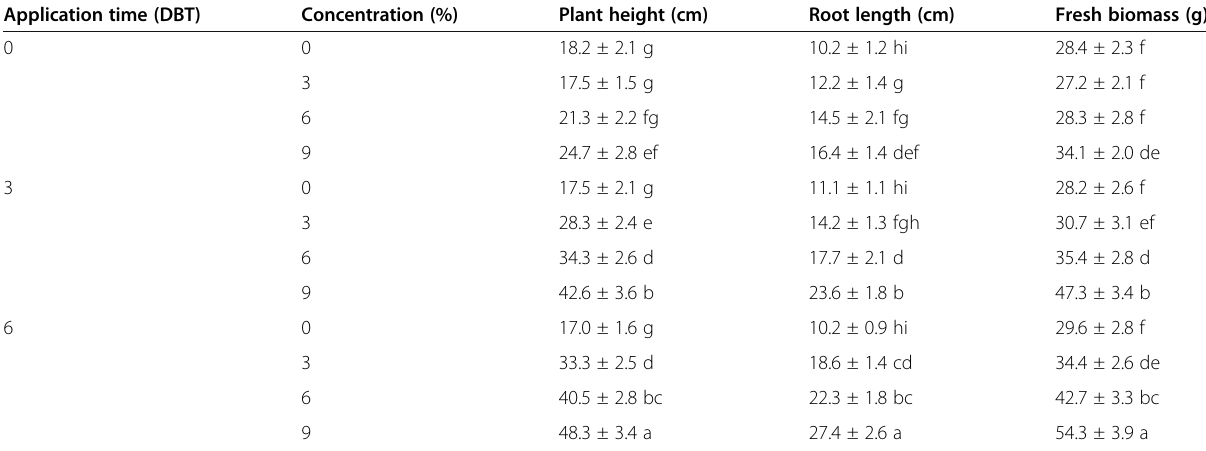
Table 2 Effect of fungal metabolites on the growth of tomato plants inoculated with R. solanacearum under greenhouse conditions (experiment